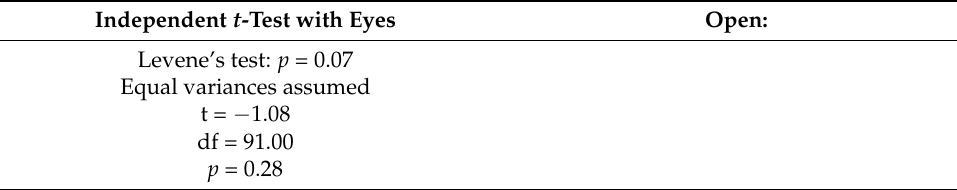
Table 4. Results of t -test of the RGB value of the edge. Independent t -Test with Eyes